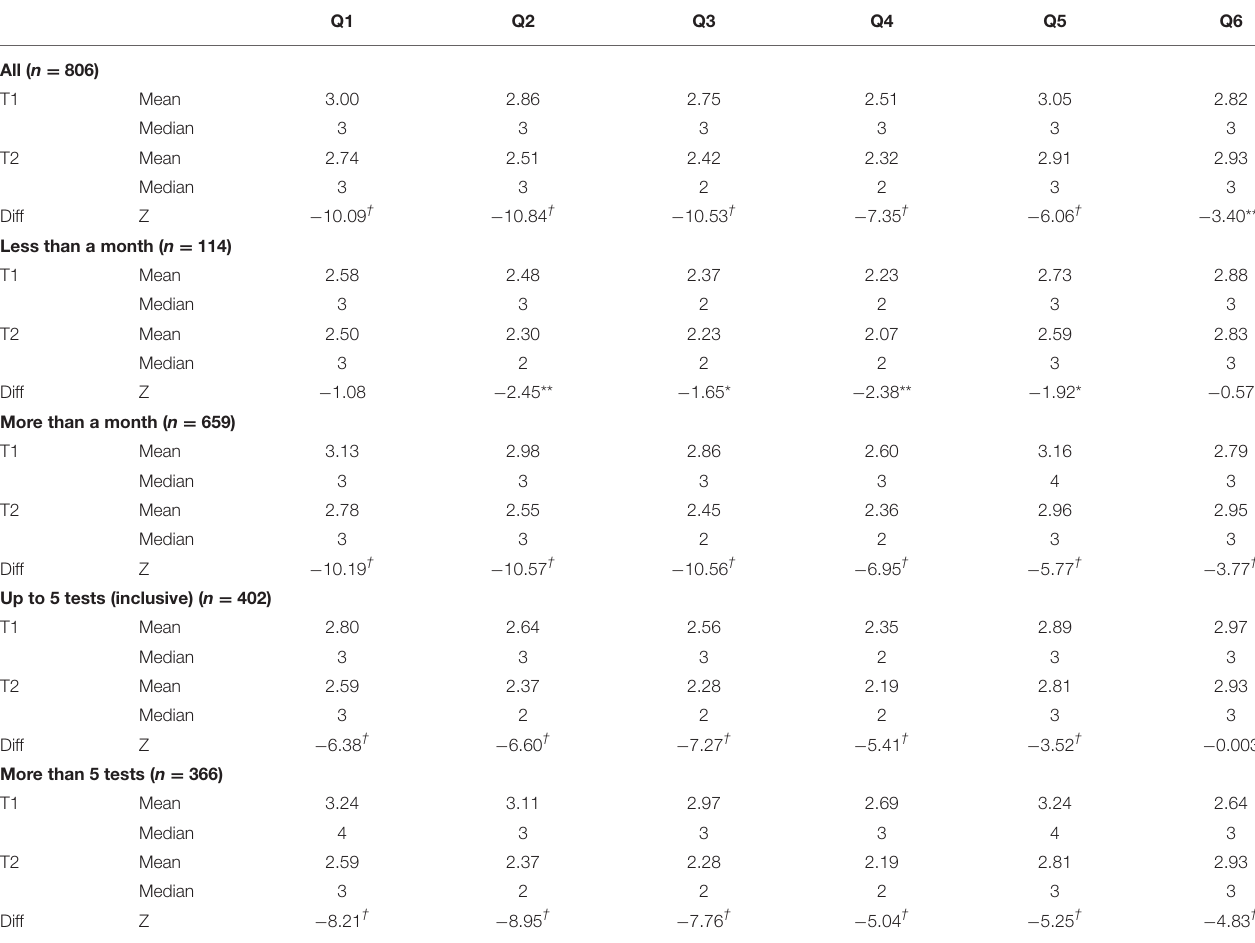
TABLE 2 | COVID-19 testing perceptions–the first test and the last test in the classification of time between tests and the number of tests. Q1 Q2 Q3 Q4 Q5